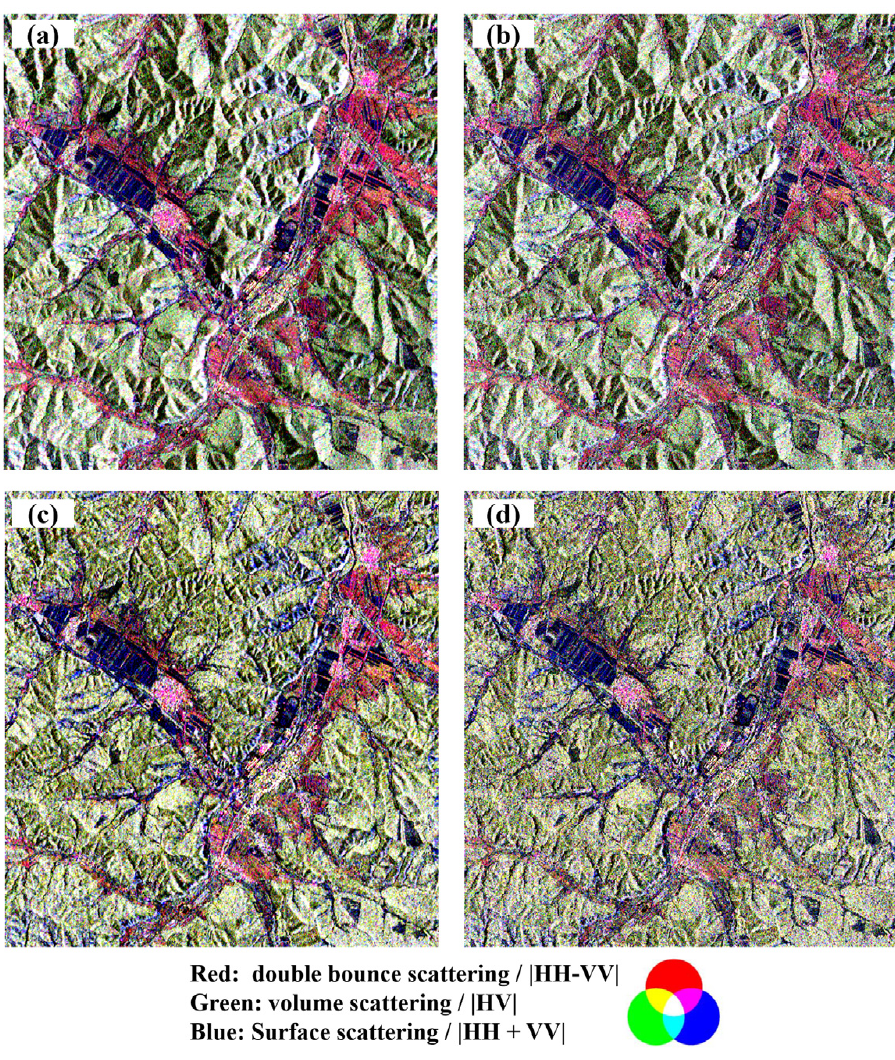
Figure 11. The enlarged Pauli RGB: ( a ) GTC result based on RPC model; ( b ) GTC result based on RD model; ( c ) RTC result based on RPC model; ( d ) RTC result based on RD model.